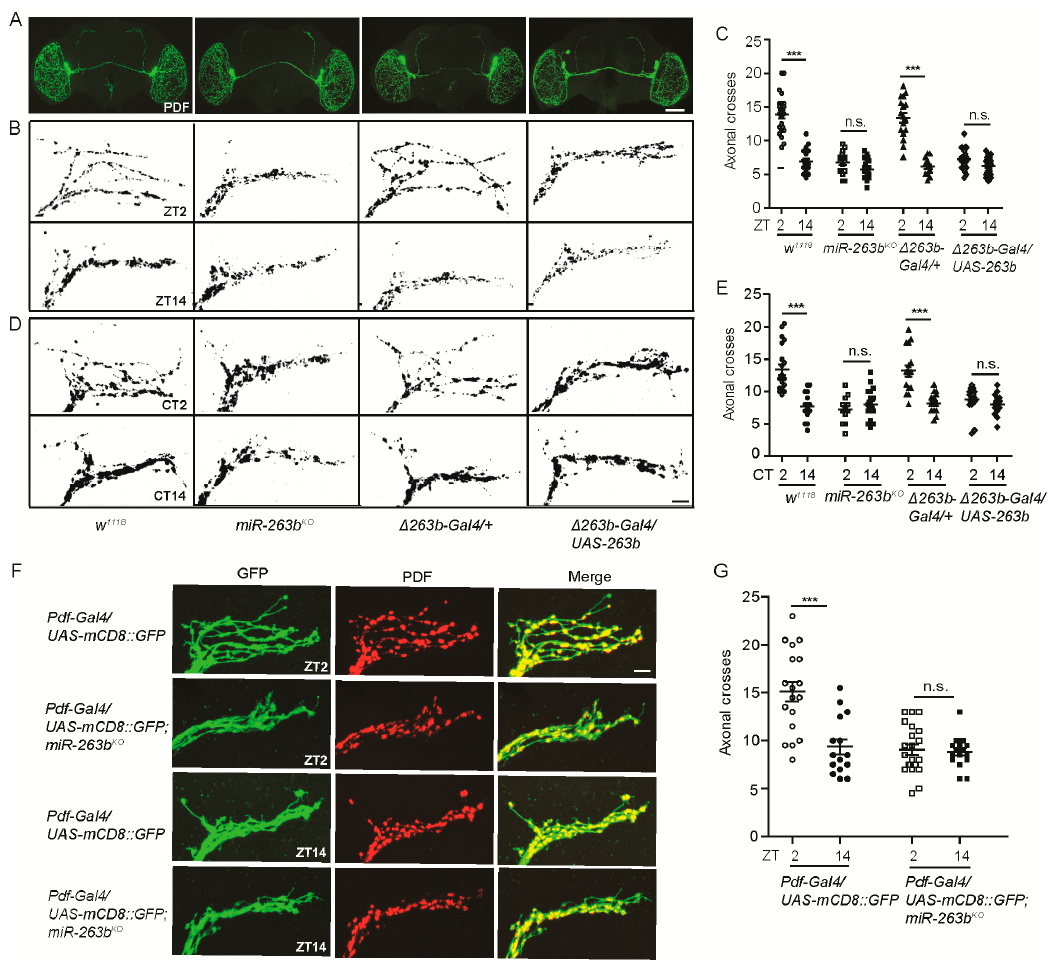
Figure 2. miR-263b modulates the structural plasticity of small ventral lateral neuron (sLNv) axonal projections. ( A ) Representative confocal images of whole brains from the indicated genotypes stained for pigment dispersing factor (PDF) at Zeitgeber time 2 (ZT2); scale bar, 75 µ m. ( B ) Representative images of sLNv dorsal projections from the indicated genotypes stained with anti-PDF at ZT2 and ZT14. Flies were entrained for at least three days under LD conditions prior to the assay. Note the “open”, defasciculated axonal conformation at ZT2 and fasciculated axons at ZT14 in control w1118 flies; scale bar, 10 µ m. ( C ) Quantification of axonal morphology (fasciculation) of sLNv dorsal termini in LD conditions by Sholl’s analysis (see also Methods). Data represent means ± SEM ( n = 15–22); n.s. not significant, *** p < 0.001 determined by Student’s t -test. ( D ) Representative images of sLNv dorsal projections from the indicated genotypes stained with anti-PDF at circadian time 2 (CT2) or CT14 during the second day of DD; scale bar, 10 µ m. ( E ) Quantification analysis of axonal morphology of sLNv dorsal termini in DD conditions. Data represent means ± SEM ( n = 15–21); n.s. not significant, *** p < 0.001 determined by Student’s t -test. ( F ) Structural plasticity of sLNv dorsal projections is regulated by miR-263b . Axonal projection of sLNv labeled by a membrane-tethered GFP. Representative confocal images of fly brains stained for GFP (green) and PDF (red) dissected at ZT2 and ZT14; scale bar, 10 µ m. ( G ) Quantification analysis of axonal morphology of sLNv dorsal termini. Data represent means ± SEM ( n = 15–21); n.s. not significant, *** p < 0.001 determined by Student’s t -test.